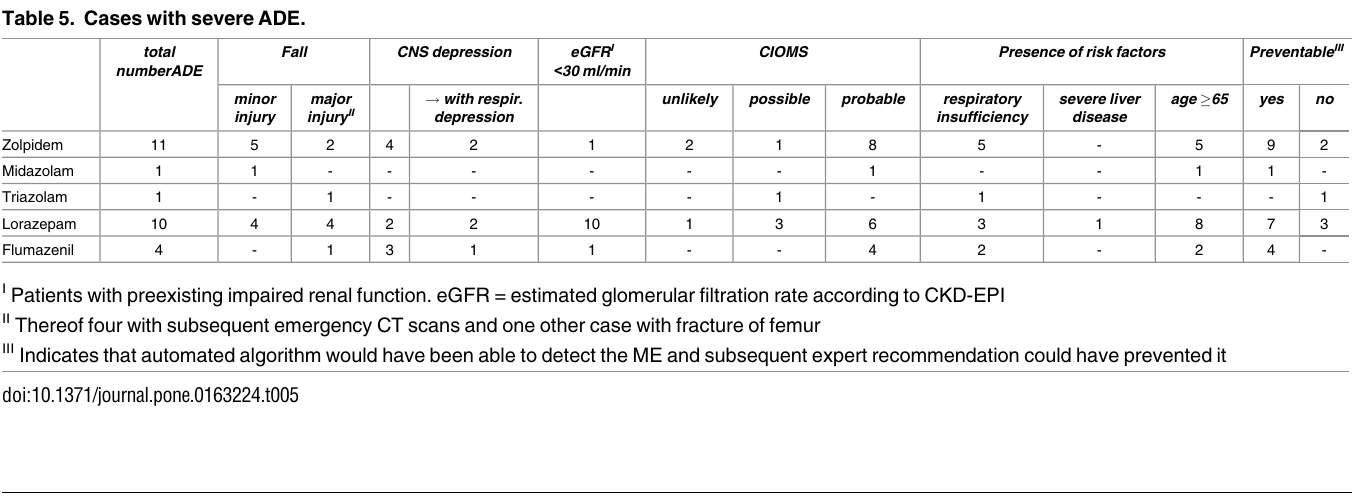
CYP inhibitor and concomitant administration of another BDZ. On the other hand, causality of one ADE with tetrazepam was assessed as ‘possible’ and found not to be preventable during hospitalization, as BDZ administration and the ADE had actually occurred before admission. Finally, the identification of all flumazenil administrations in our dataset revealed four cases of severe ADE resulting from inadequate BDZ administrations during hospitalization. In two of those preventable ME strong CYP inhibitors had been co-administered with BDZ while in one case lorazepam had been administered in a patient with severe renal impairment (eGFR of 18 ml/min). Additional relevant CYP inhibitors and administration of multiple BDZ were also present in all four cases.